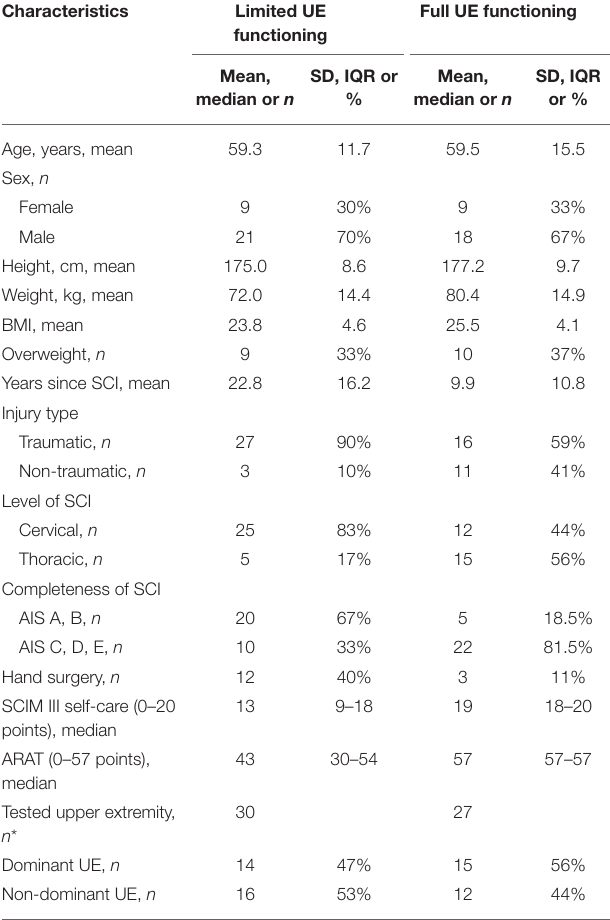
TABLE 1 | Characteristics of the individuals with spinal cord injury (SCI) included in the limited and full upper extremity functioning groups.